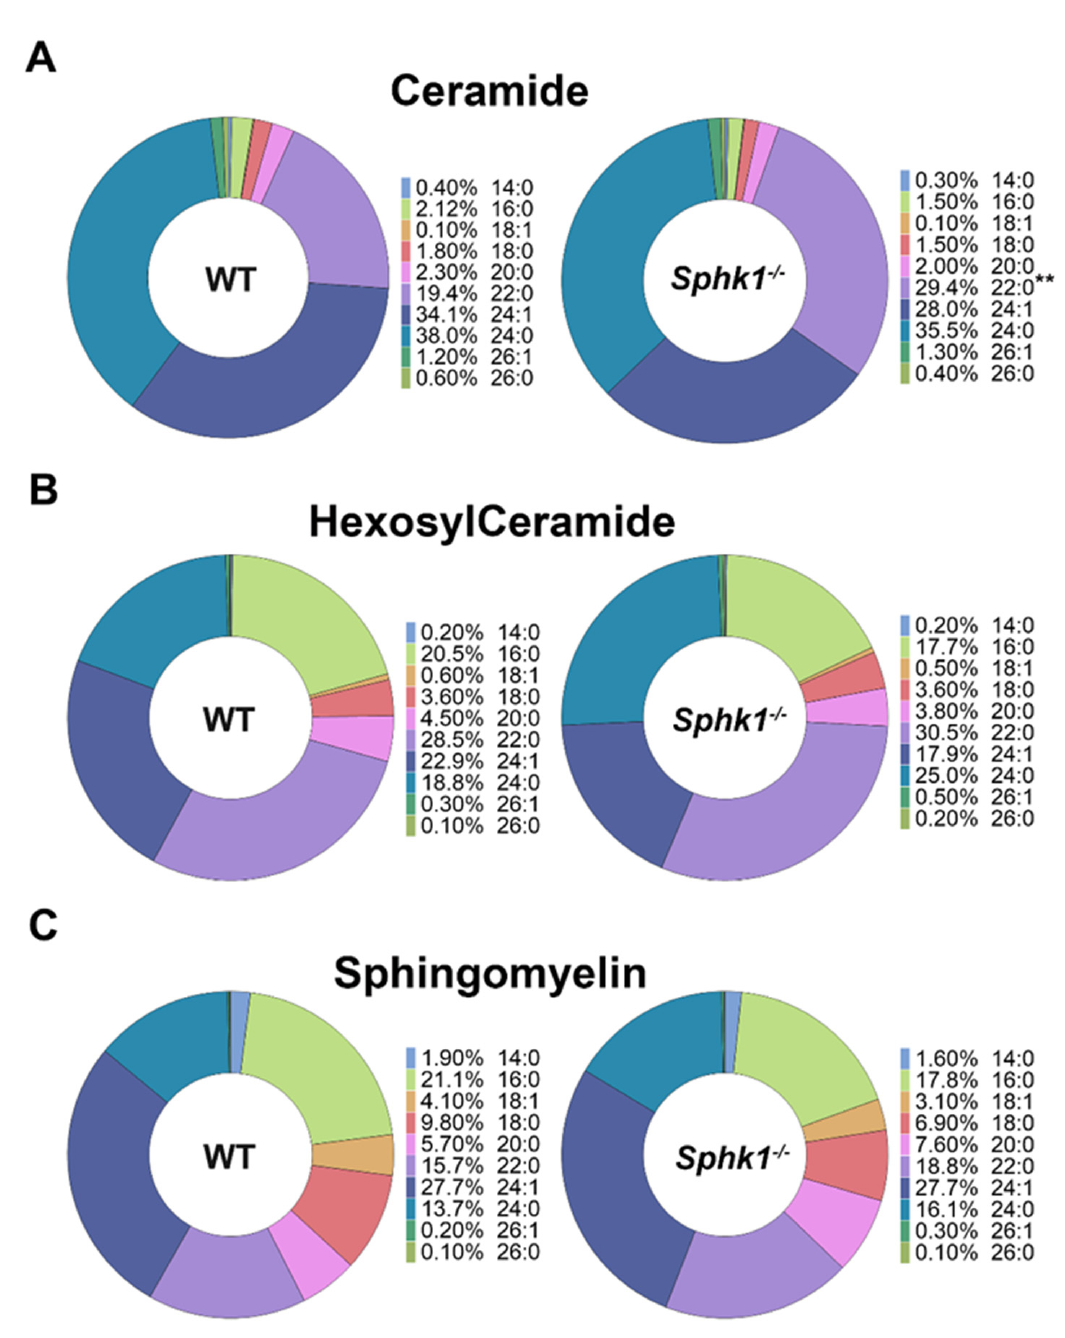
Figure 2. Plasma sphingolipids were altered in Sphk1 − / − mice. Sphingolipid analysis of WT and Sphk1 − / − mice plasma ( n = 5) showing mole percent composition of ( A ) ceramide, ( B ) HexCer, and ( C ) sphingomyelin. (Values are mean ± SD, ** p ≤ 0.001).